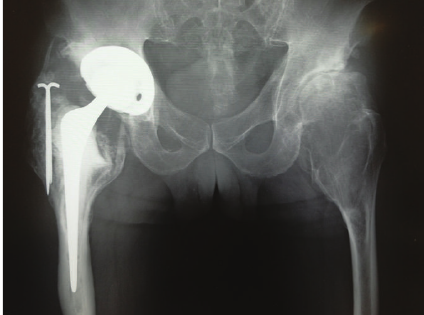
Figure 8: Anteroposterior radiograph of the pelvis taken 13 months postoperatively showing ectopic